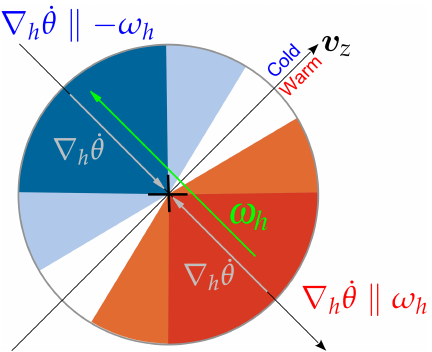
Figure 1. Conceptual model of upper-level PV modification by a convective updraft ( + ) that is located in an environment with back- ground horizontal vorticity. Variables are shown as follows: vertical wind shear vector ( v z , black) with the cold air on the left, the hor- izontal vorticity vector ( ω h , green), the diabatic heating gradients pointing radially toward the convective updraft ( ∇ h ˙ θ , grey), and the regions where PV is destroyed (blue shading) and where PV is generated (red shading) because ∇ h ˙ θ (cid:107) − ω h and ∇ h ˙ θ (cid:107) ω h , respec- tively (see Eq. 4 and Schemm, 2013). The intensity of the blue and red shading schematically represent the degree of PV change. See text for details. Note that the orientation of the vertical wind shear vector and the PV dipole schematically represents the synoptic sit- uation shown in Fig.